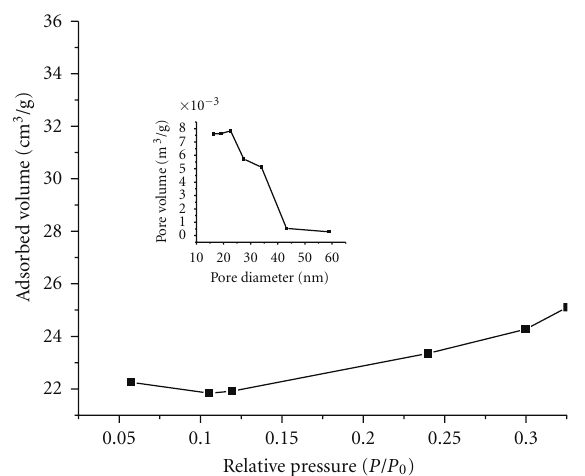
Figure 4: Nitrogen adsorption-desorption isotherms and corre- sponding pore size distribution. Curves (inset) of the Mg 2+ -TiO 2 prepared at 1.25 wt.% of Mg 2+ .